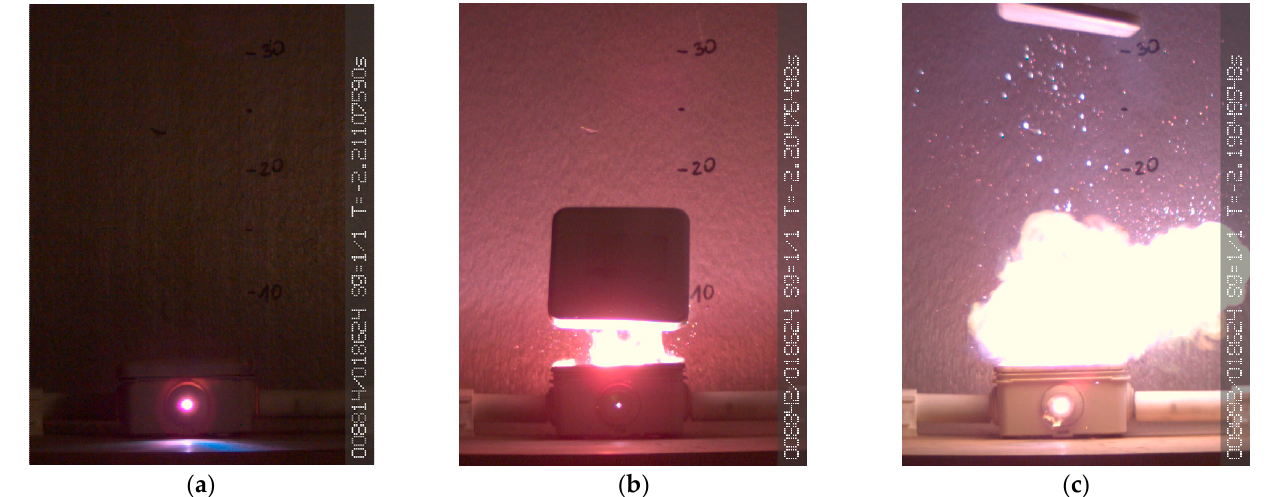
Figure 8. The waveform of the arc current i a (t) and the arc voltage u a (t) for three half-waves of the arc disturbance).